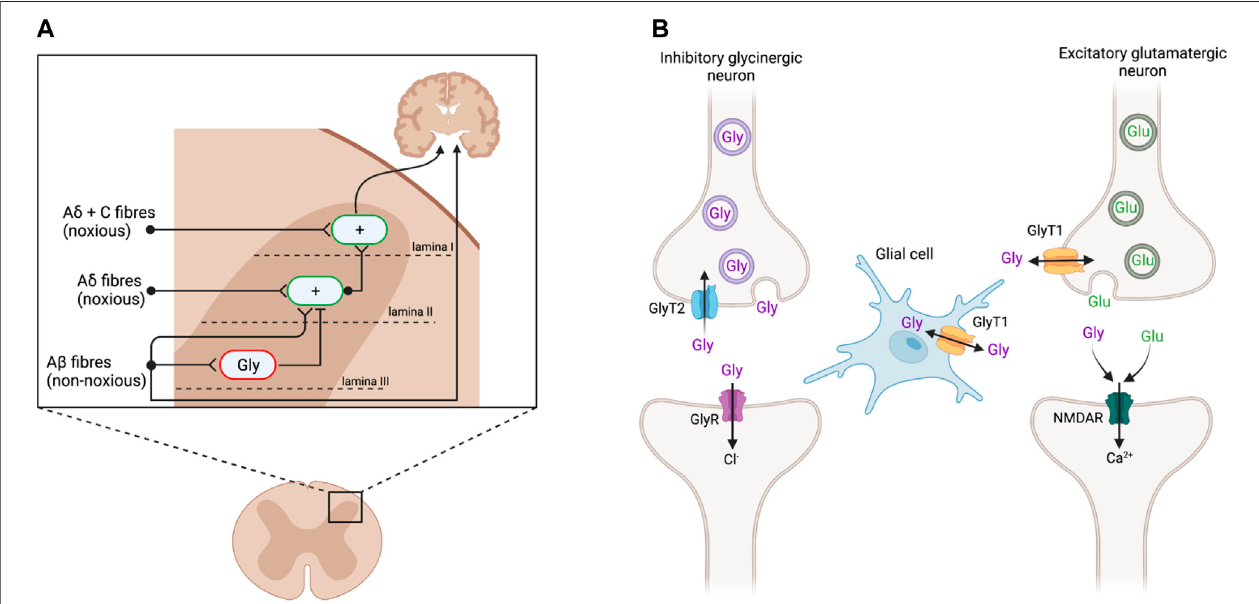
FIGURE1|(A) Sensoryinputinthedorsalhornofthespinalcord.A δ andCnerve fi bers,transmittingnoxiousstimuli,synapseonexcitatoryinterneurons(green;+) in the super fi cial laminae I and II. These signals are conveyed to the brain to elicit pain responses. Non-noxious stimuli transmitted via A β fi bers innervate inhibitory glycinergic interneurons (red; Gly) in the deeper lamina III, inhibiting the activation of lamina II excitatory interneurons and preventing ascension of the pain signal. Following peripheral nerve injury, inhibitory glycinergic activity is reduced, resulting in a disinhibition of lamina II activation such that the non-noxious stimuli activate the nociceptive pathway. Adapted from Lu et al., (2013) and Vandenberg et al., (2014). (B) Glycinergic neurotransmission at inhibitory glycinergic and excitatory glutamatergicsynapses.Atinhibitoryglycinergicsynapses,glycineactivatesGlyRs,causinganin fl uxofchlorideionstohyperpolarizethepostsynapticcellandinhibitthe ascending pain signal. The concentration of glycine at GlyR (purple) is regulated by GlyT2 (blue), which transports excess glycine in the synaptic cleft back into the presynaptic cell for vesicular re fi lling. GlyT1 (yellow) regulates glycine and glutamate concentrations at NMDAR (green). Adapted from Supplisson and Roux (2002) and Vandenberg et al., (2014). Created with